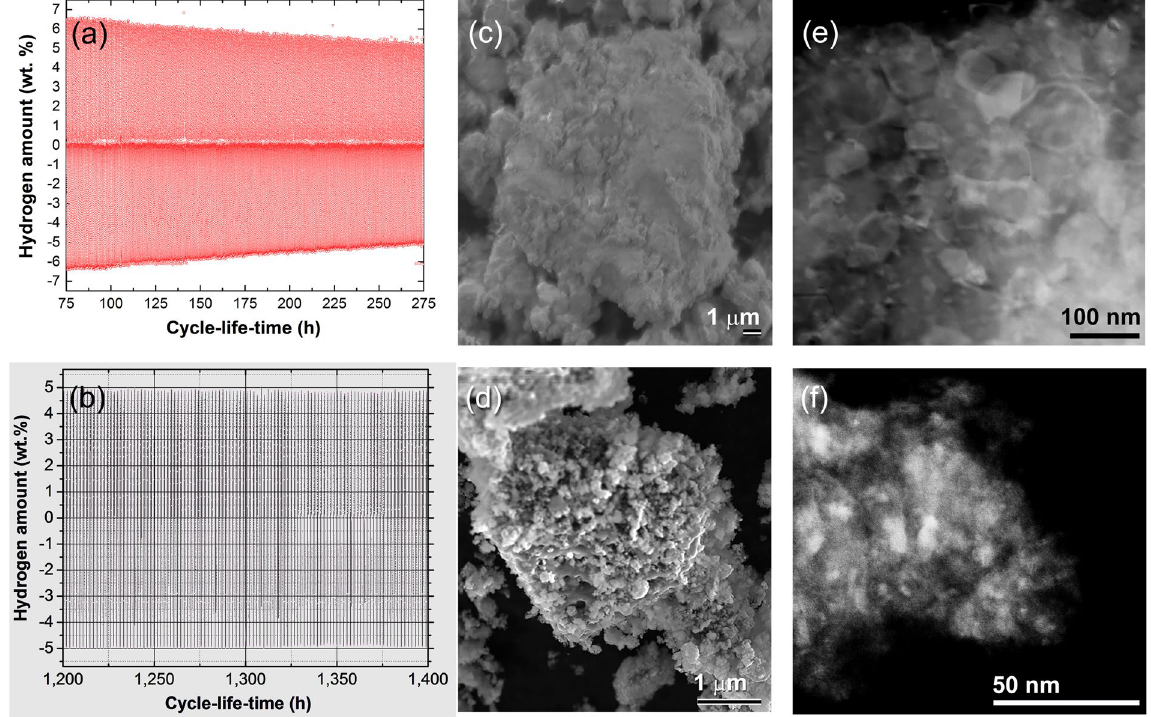
Figure 8. Influence of cycle-life-time and TiMn 2 additives on the morphological characteristics of the powders. The cycle-life-time of the last 200 h for ( a ) nanocrystalline MgH 2 powders, and ( b ) nanocomposite MgH 2 /5 wt.% TiMn 2 powders. The FE-SEM micrographs of the powders obtained after completion the cyclic hydrogenation tests displayed in ( a , b ) are shown in ( c , d ), respectively. STEM-DFIs of the powders obtained after completion 275 h cycle-life-time (MgH 2 powders) and 1400 h (MgH 2 /5 wt.% TiMn 2 powders) are shown in ( e , f ),